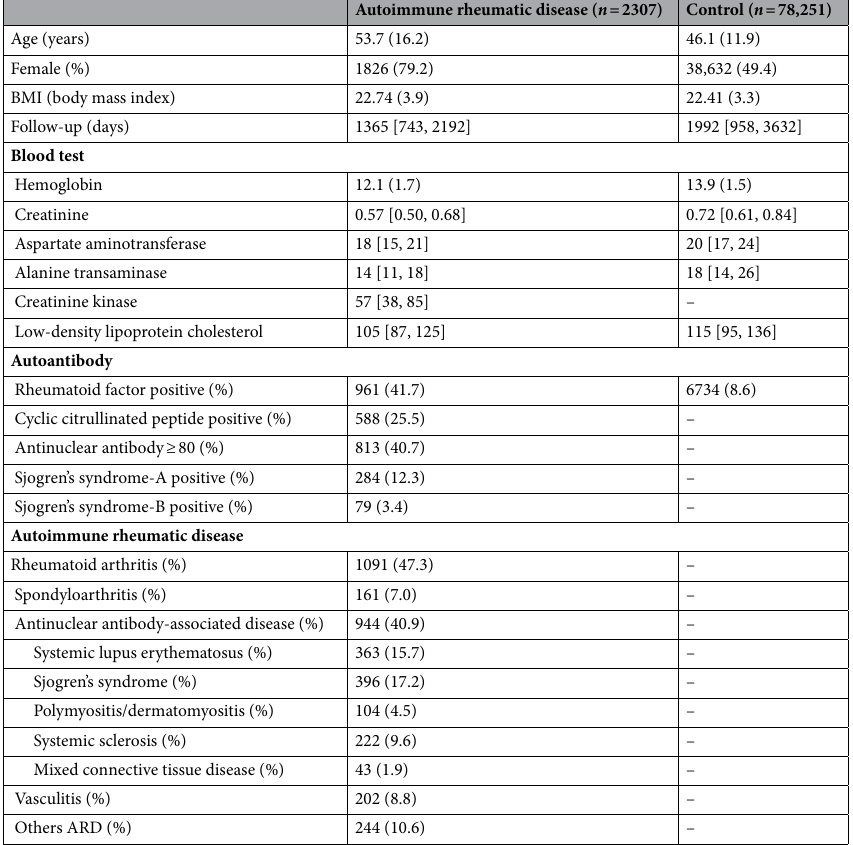
Table 1. Baseline characteristic of autoimmune rheumatic disease patients and controls. Variables are shown as mean ( SD standard deviation) or median ( IQR interquartile